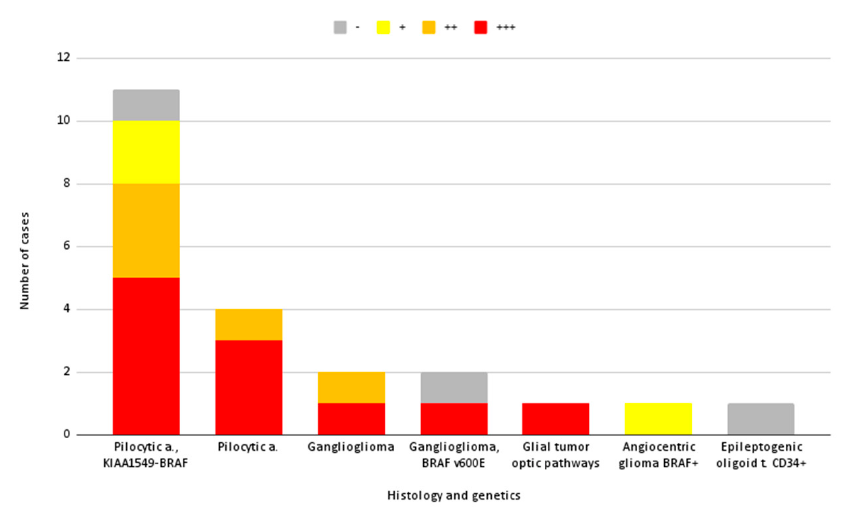
Figure 2. Intensity of intraoperative fluorescence for each histology and molecular characteristics. +++: intense; ++: moderate; +: modest; -: absent fluorescence.